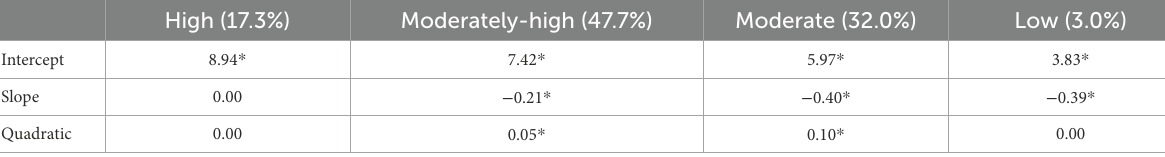
TABLE 5 Estimates for self-compassion trajectory